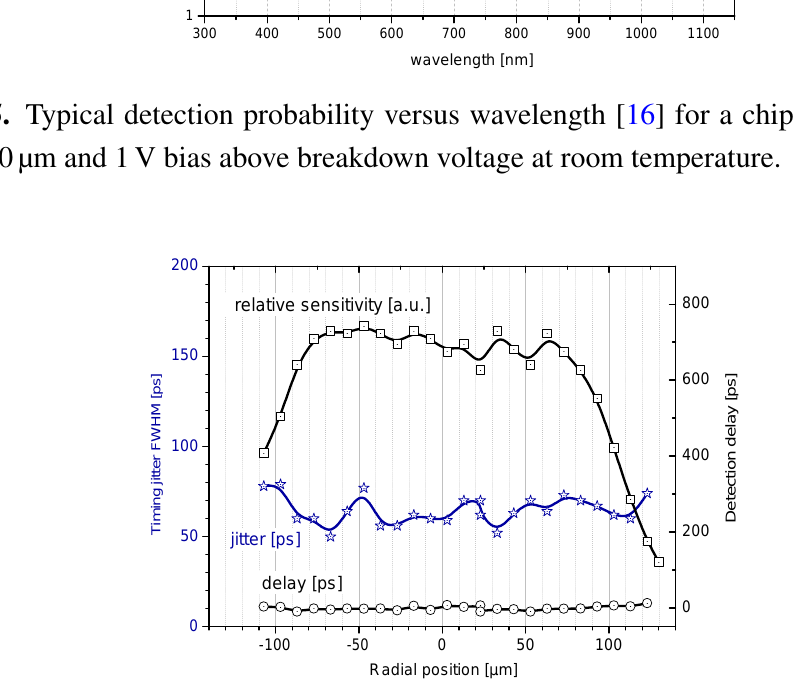
Figure 6. Uniformity of a typical 200 µm K14 SPAD. Note the detection delay, independent on position of seed